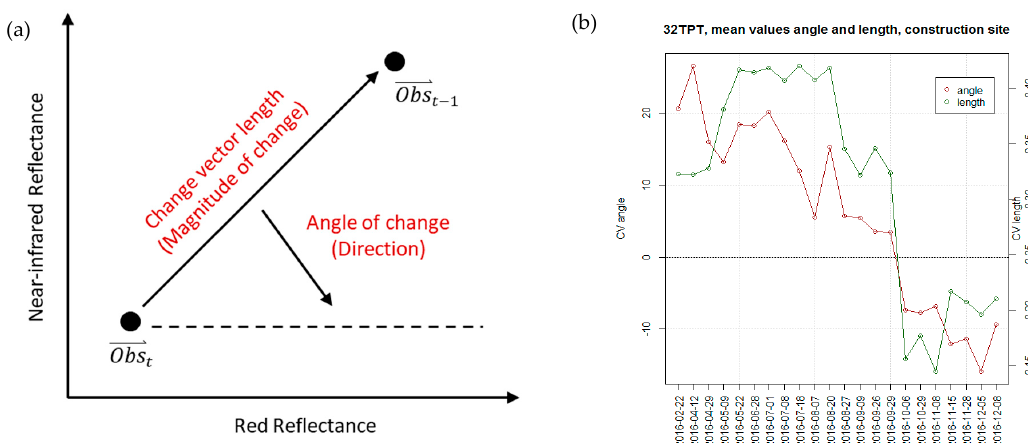
Figure 2. ( a ) Length and angle of the change vector in the red (band4)-NIR-space as used in the change detection analysis herein. ( b ) A time series of the mean values of angle and length for a typical construction site with the significant change occurring end of September 2016.